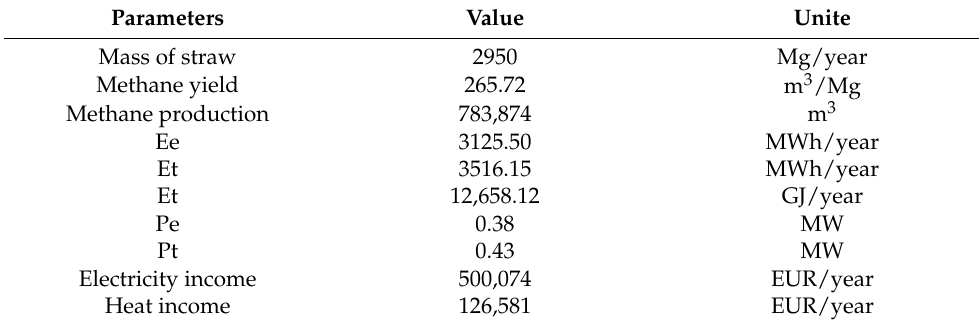
Table 9. Energetic and economic calculations of produced methane using straw as a